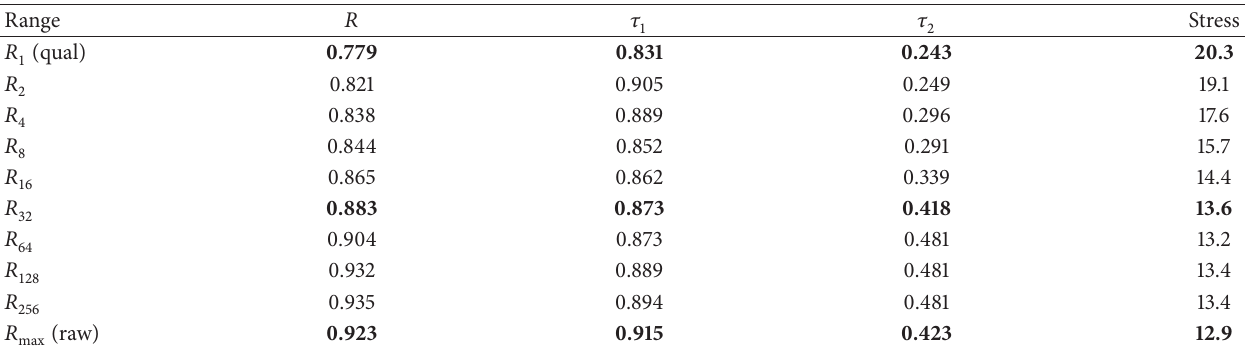
Table 3: Procrustes correlation coefficients ( 𝑟 ) between parallel DCA and GNMDS ordinations, Kendall’s tau correlations ( 𝜏 1 and 𝜏 2 ) between corresponding axes for each abundance range ( 𝑅 1 – 𝑅 max ), and percent stress for GNMDS ordinations. The abundance ranges indicated by bold-face numbers represent no ( 𝑅 1 ), intermediate ( 𝑅 32 ), and a strong ( 𝑅 max = 571) weight given to abundance (see Section 2.6 for explanation of selection